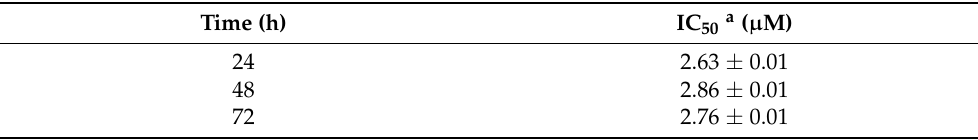
Figure 2. Cytotoxic effects of plumbagin on MCF-7 cells. MCF-7 cells were treated with 1, 2, and 4 µ M of plumbagin for ( A , B ) 24 h, ( C , D ) 48 h, and ( E , F ) 72 h. The MCF-7 cell viability was measured by MTT assay. Data are means ± SEM compared with the control from three independent experiments ( n = 3). * p < 0.05 vs. control. Table 1. The IC 50 values of plumbagin for MCF-7 cells with different exposure times.